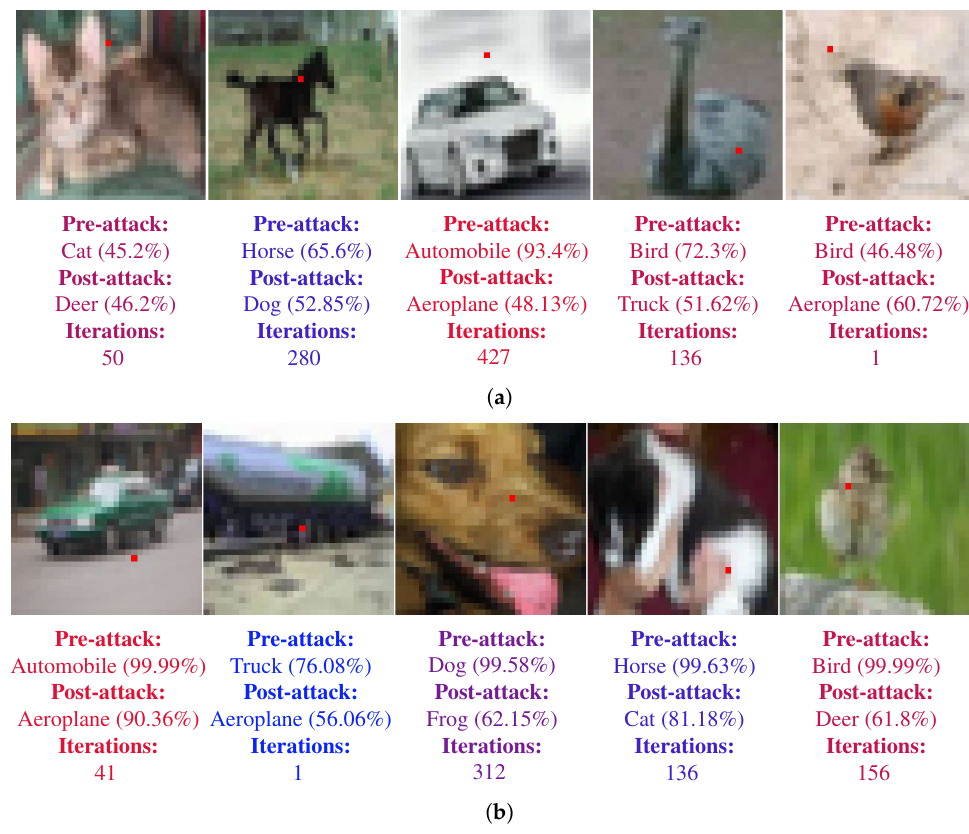
Figure 9. Samples of single pixel successful untargeted attacks on LeNet-5 and ResNet architectures. Perturbed pixel is marked as red. The pre-attack, post-attack predictions and confidences along with the number of iteration required to fool the CNN are also shown below the images. ( a ) Samples for LeNet-5. ( b ) Samples for